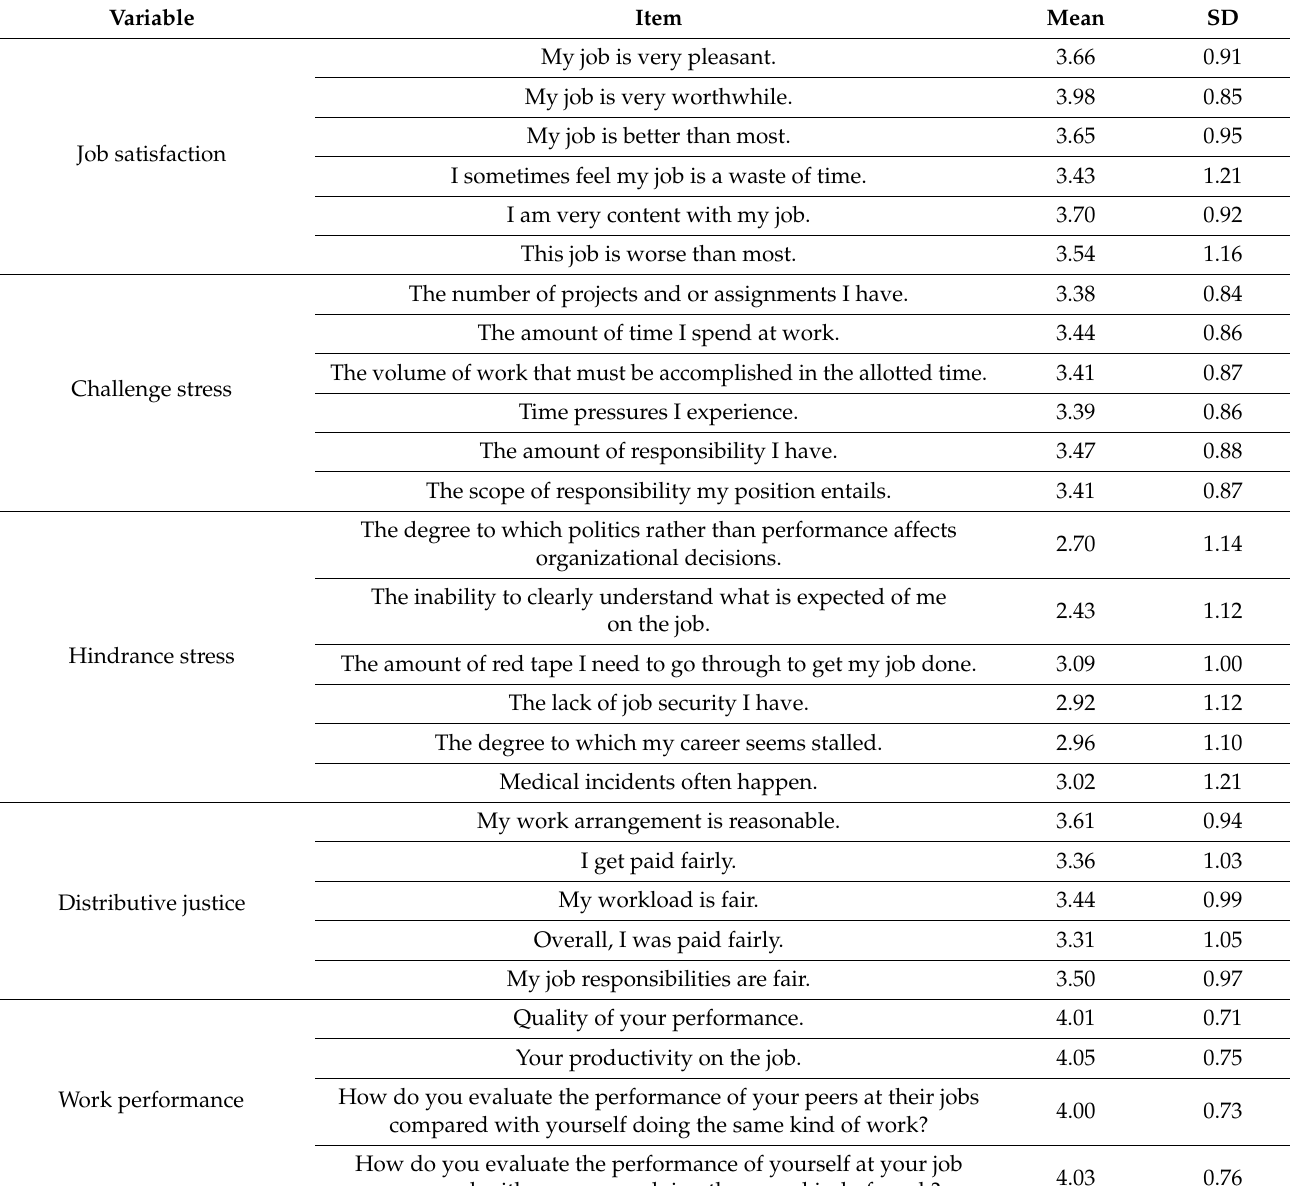
Table 4. Healthcare workers’ subjective perception measurement statistics